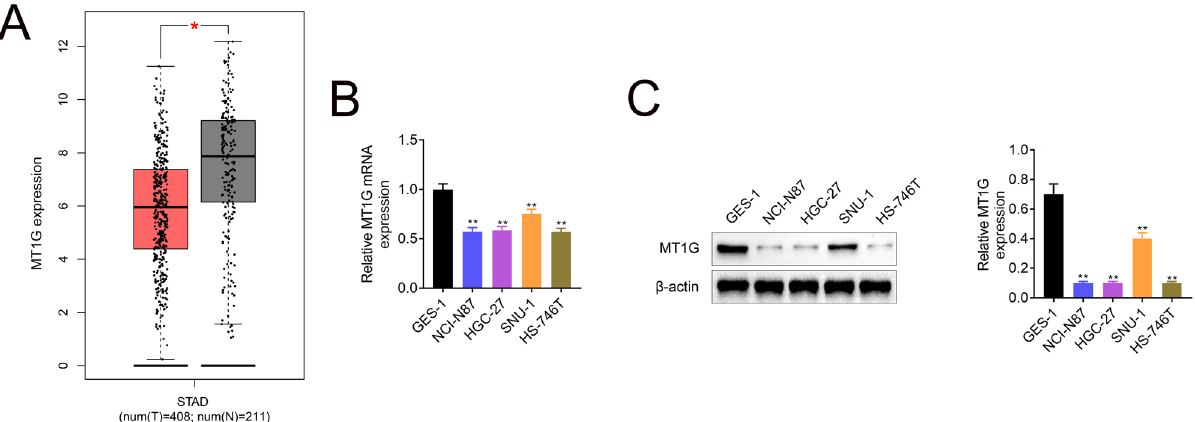
Figure 1 – MT1G is low expression in gastric cancer tissues and cells. (A) The expression of MT1G in GC tissue and para-carcinoma normal tissue specimens was determined from TCGA analysis. (B&C) The expression of MT1G in GC cells was measured by RT-qPCR (B) and western blotting (C). Error bars represent data from three independent experiments (mean±SD). * P<0.05, **